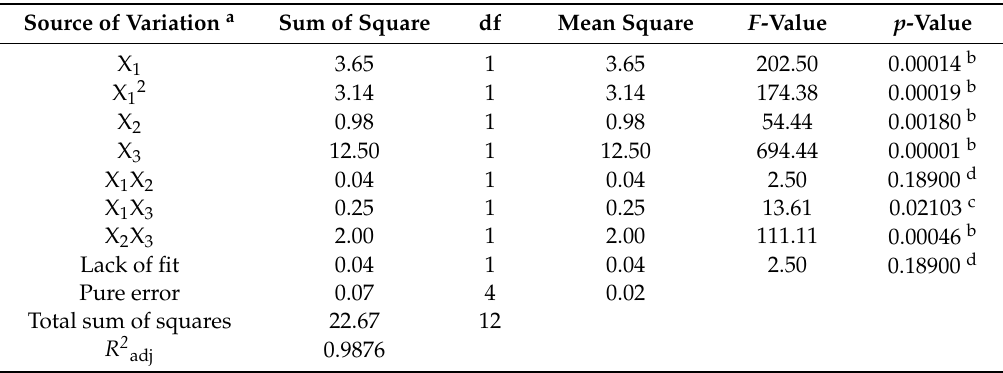
Table 2. Analysis of variance (ANOVA)